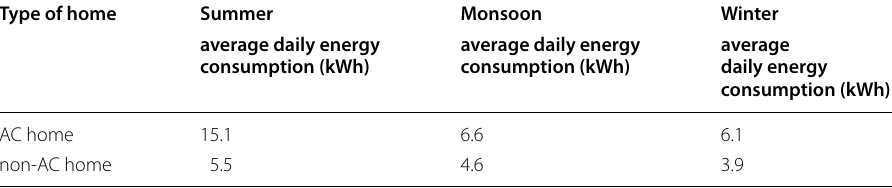
Table 4 Average energy consumption per day of AC and non-AC homes for each season Type of home Summer Monsoon Winter average daily energy average daily energy average consumption (kWh) consumption (kWh) daily energy consumption (kWh) AC home 15.1 6.6 6.1 non-AC